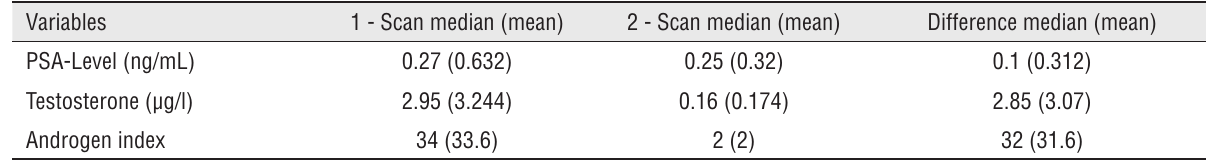
Table 3 - PSA and testosterone levels before and after androgen deprivation (n=5).